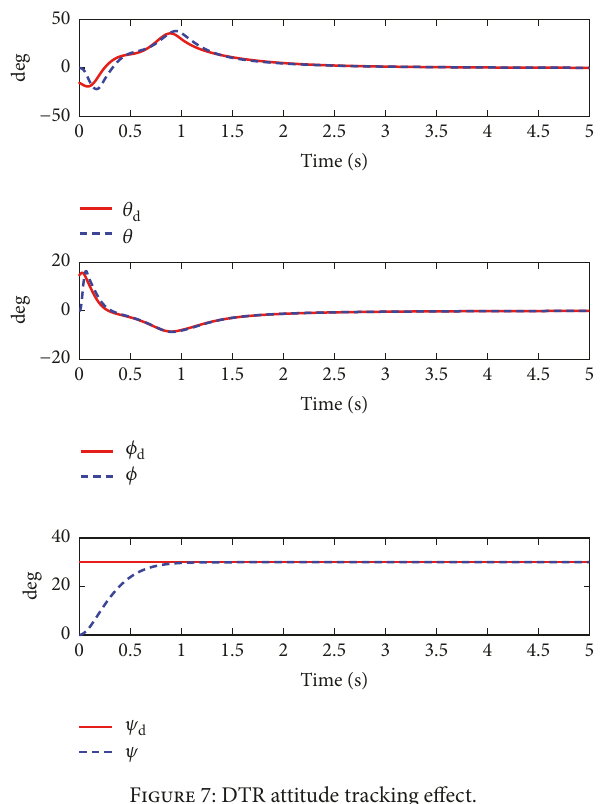
Figure 7: DTR attitude tracking effect.